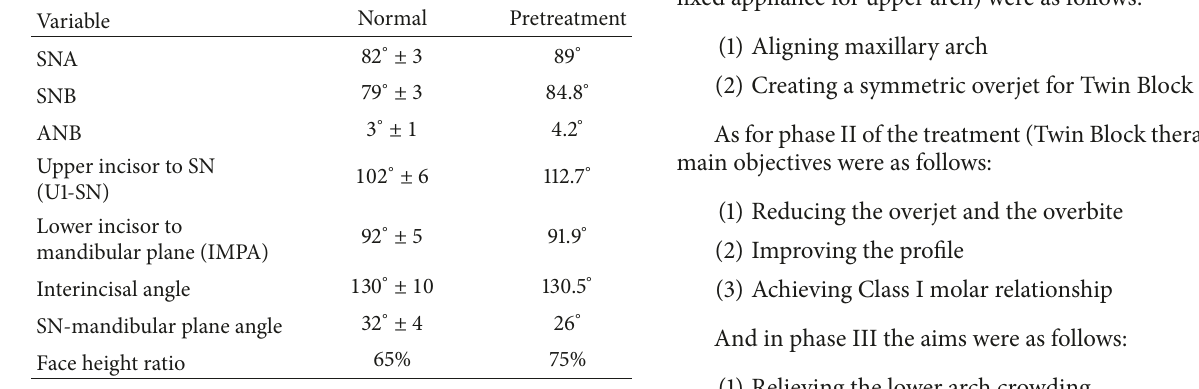
∘ ± 3 89 ∘ ∘ ± 3 84.8 ∘ ∘ ± 1 4.2 ∘ 102 ∘ ± 6 112.7 ∘ 92 ∘ ± 5 91.9 ∘ ∘ ± 10 130.5 ∘ ∘ ± 4 26 ∘